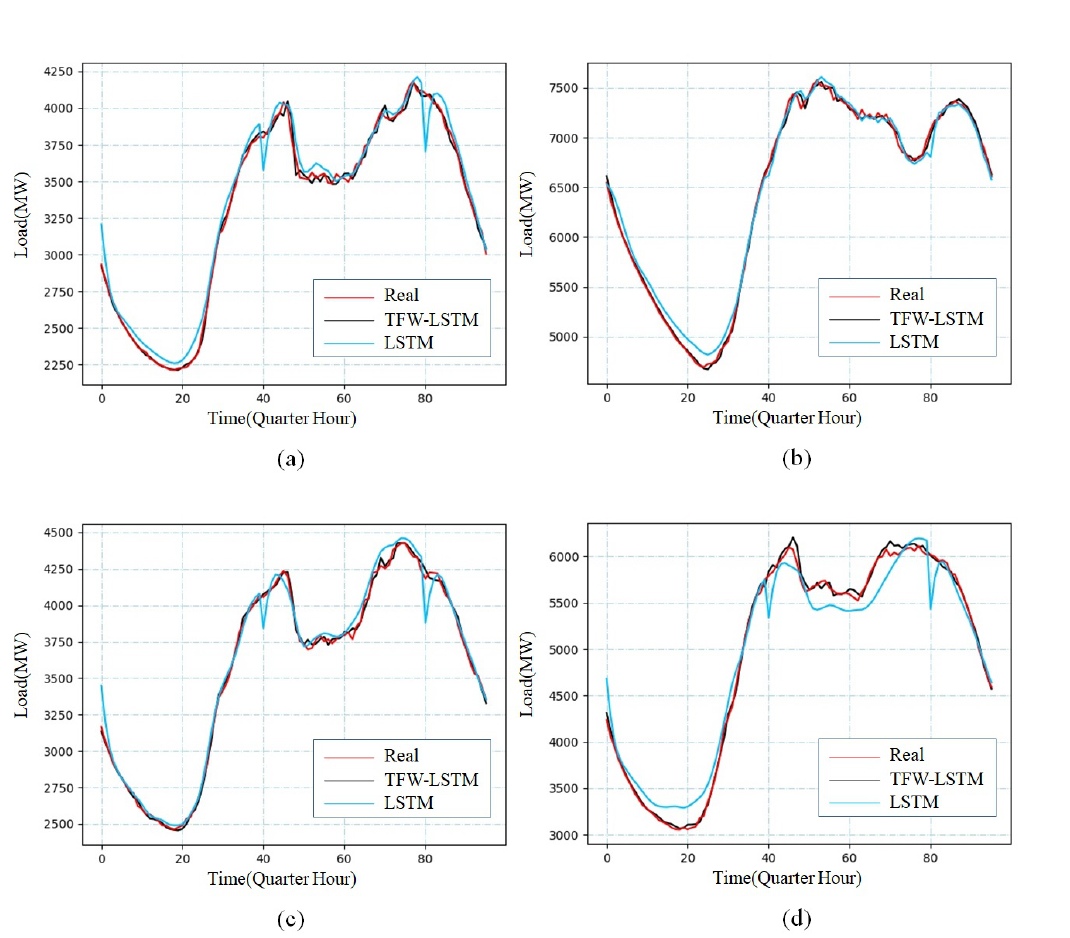
Figure 8. Prediction results for ( a ) 20 March 2019, ( b ) 31 July 2019, ( c ) 7 November 2019, and ( d ) 24 Decmber 2019. The “Real” stands for the actual value, and the TFW-LSTM is our method, the “LSTM” is the traditional LSTM